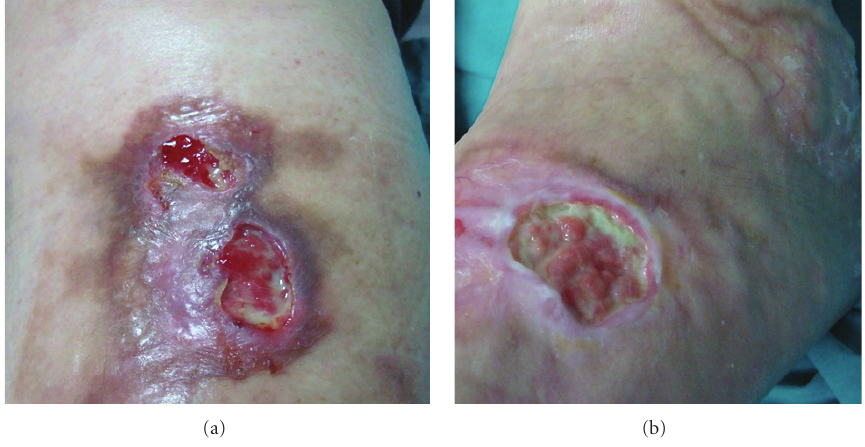
Figure 1: Ulcerative lesions on the patients’ shins (a) and feet (b).